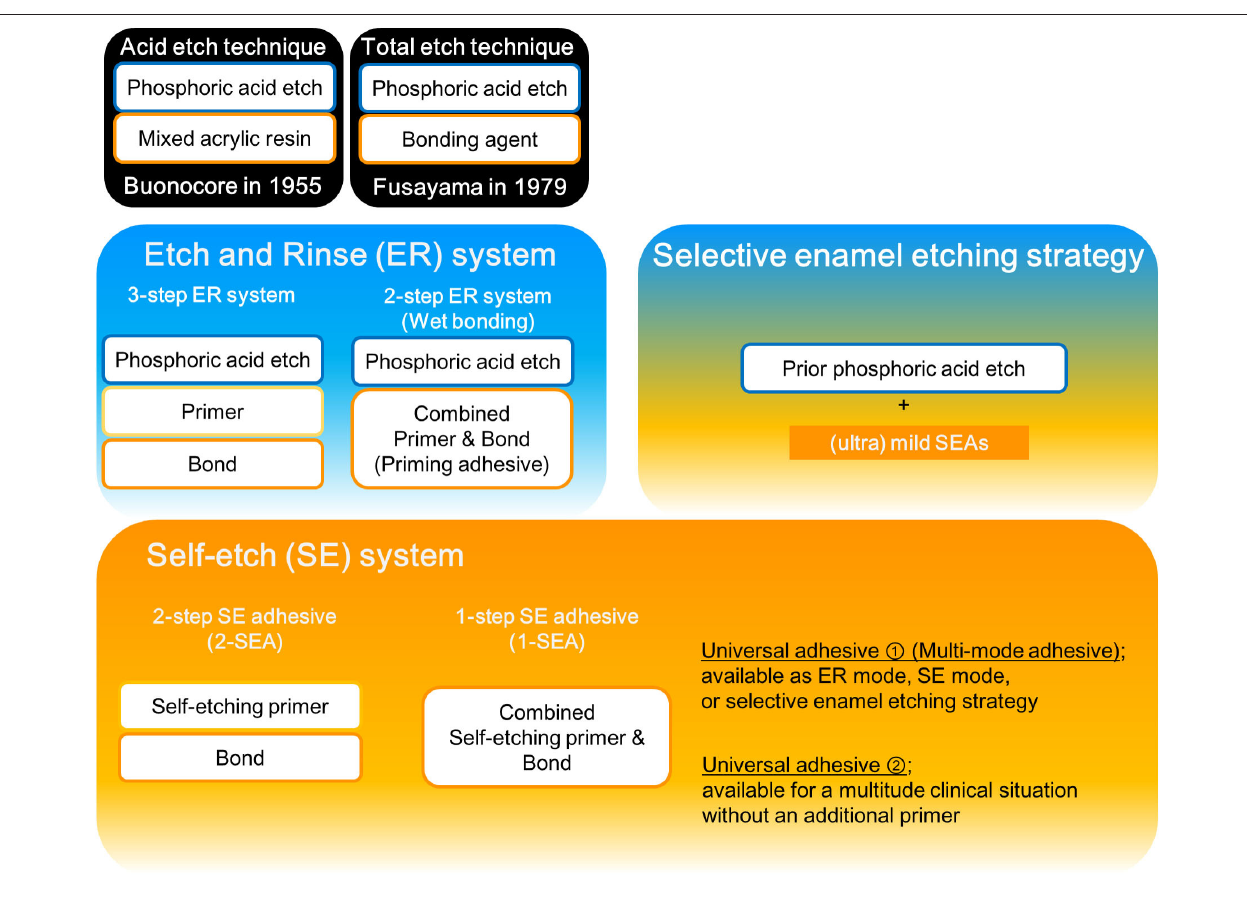
adhesive resin is applied to the tooth. The advantage of 2-SEA is that their efficacy appears to be less dependent on the hydration state of the dentin rather than the ER adhesives